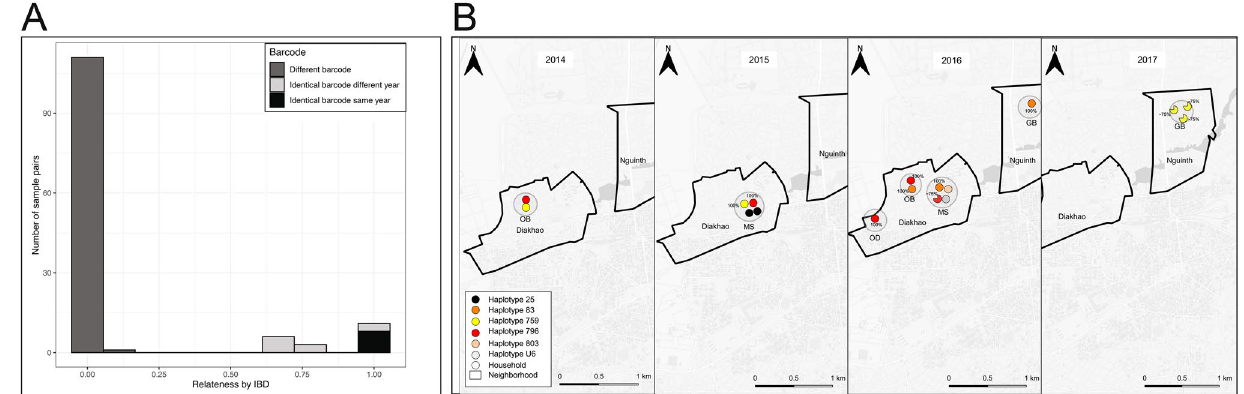
Figure 5. Identity by Descent reveals subtle differences among identical barcode samples separated in time. ( A ) Relationship between identical barcode parasites (measured by IBS) and IBD with time. Percent of whole genome relatedness by IBD, color-coded by barcode identity (IBS), identical or different. ( B ) Relationships between 17 specific identical barcode haplotypes by household, year, and IBD, determined from whole genome sequencing. Years are shown on the X axis. Colored circles represent individual parasites from haplotypes that are color coded according to barcode haplotype. Pie charts and percentages shown represent percent IBD relative to the pairwise comparison to the initial isolate, as defined